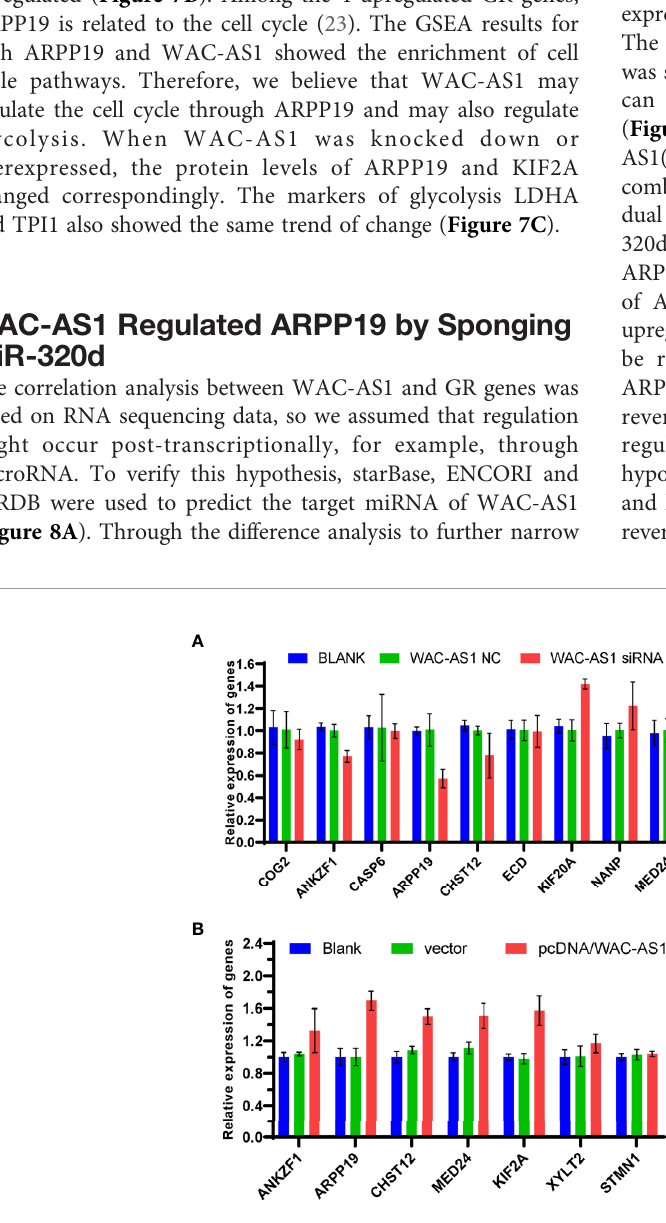
FIGURE 7 | Veri fi cation of co-expression relationships. (A) expression of GR genes in HCCLM3 cells treated with siRNA; (B) expression of GR genes in HCCLM3 cells after overexpression of WAC-AS1; (C) expression of GR genes detected by western